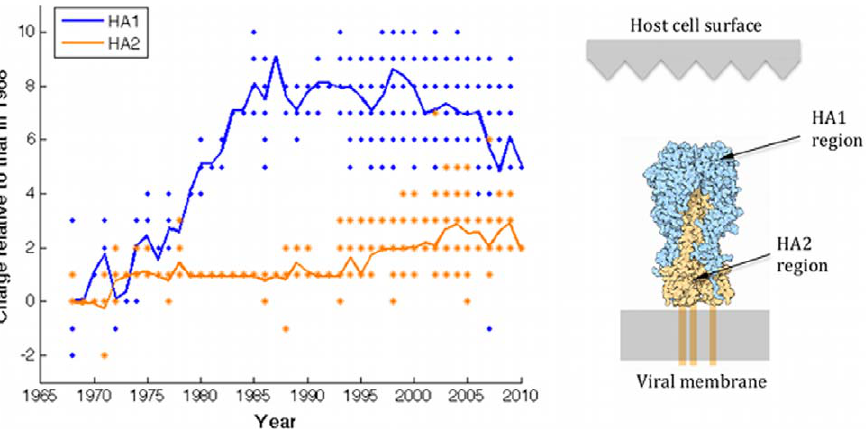
Figure 2. Comparison of changes in charge in the two subunits of the H3N2 HA molecule. Solid lines indicate mean trends. The side-bar illustrates these regions on the HA molecule (diagram source: RCSB Protein Data Bank).